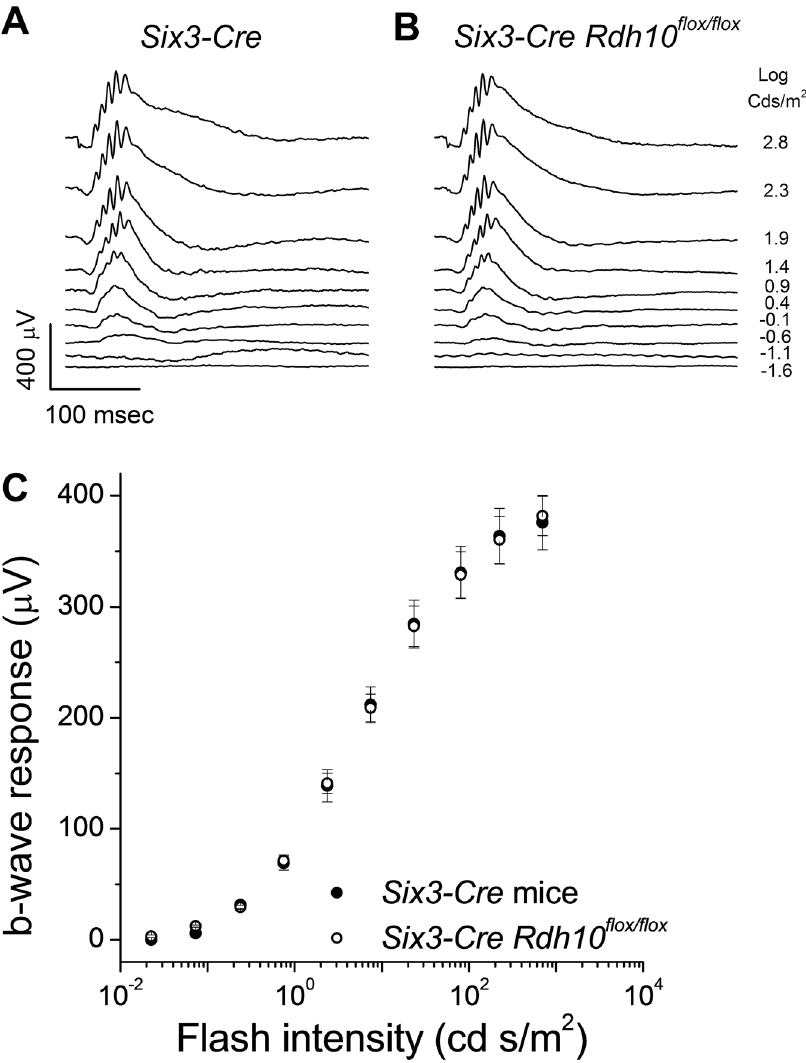
Figure 5. Deletion of RDH10 in the entire retina does not affect the photopic ERG b-wave responses in mice. Representative in vivo ERG responses of ( A ) Six3-Cre control and ( B ) retina Rdh10 knockout ( Six3-Cre Rdh10 flox/flox ) mice. ( C ) Ensemble-averaged cone b-wave intensity-response curves of Six3-Cre control mice (n = 12, filled symbols) and Six3-Cre Rdh10 flox/flox mice (n = 10, open symbols). All mice were in Gnat1 − / − background to facilitate cone